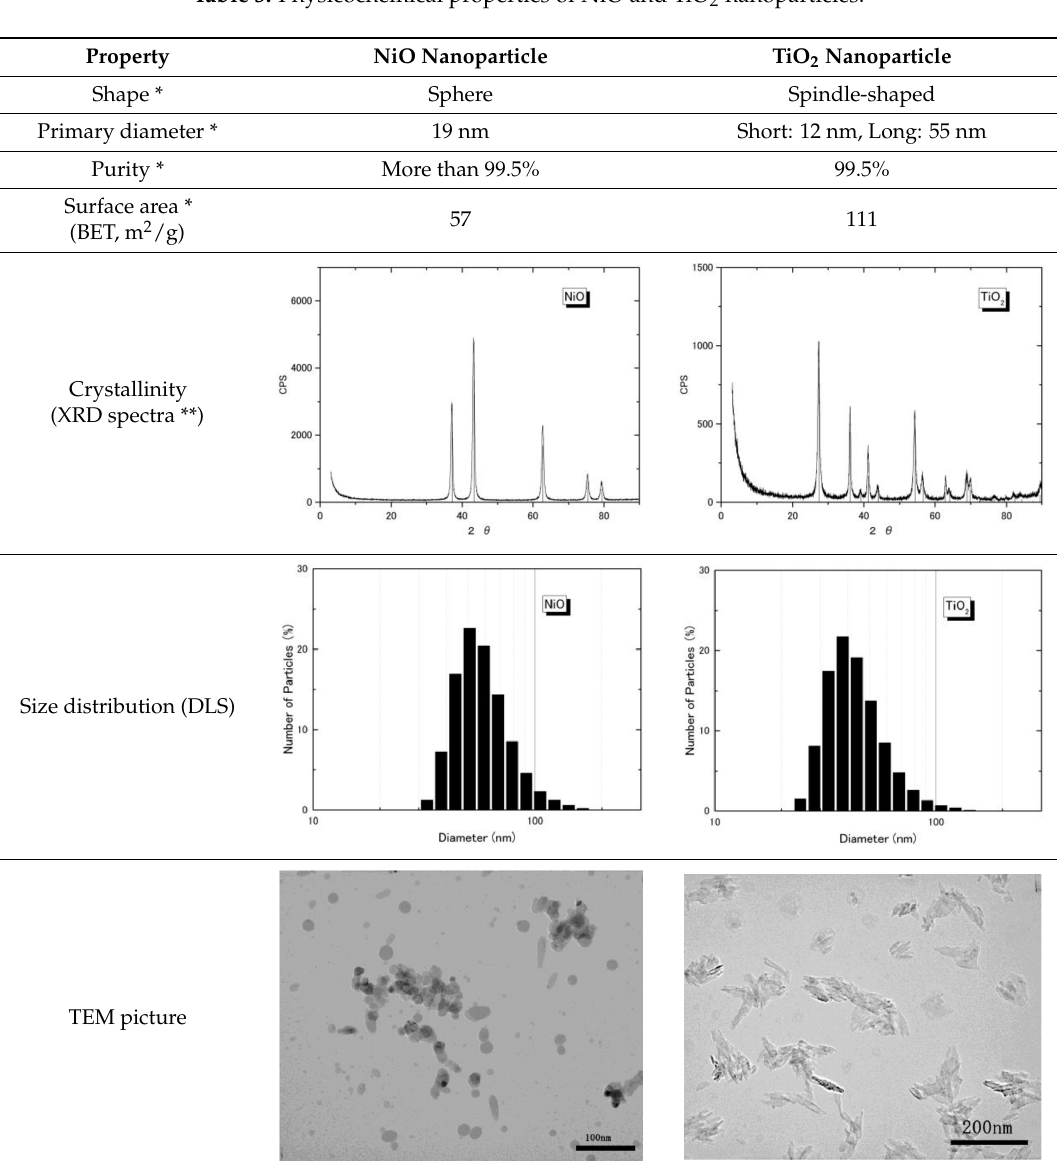
Table 3. Physicochemical properties of NiO and TiO 2 nanoparticles.